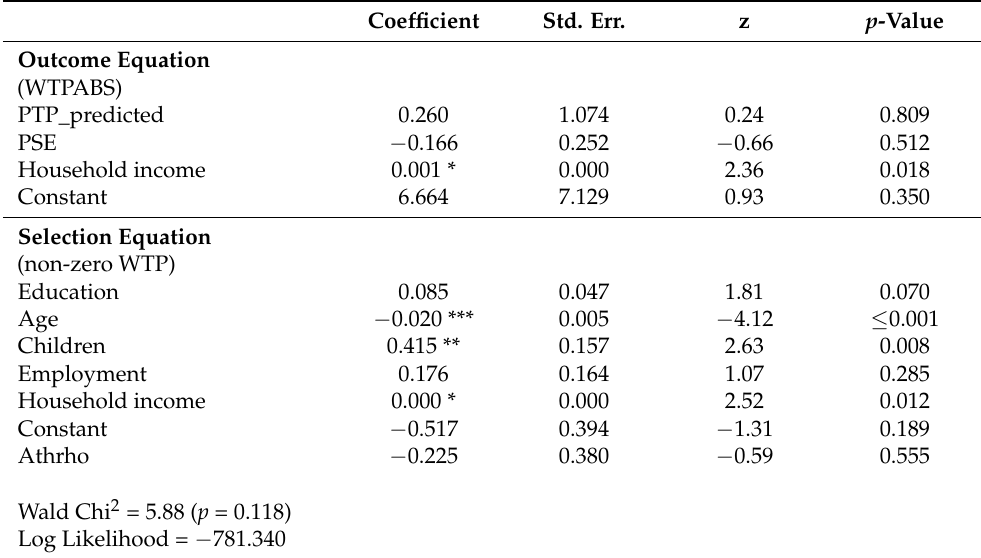
Table 5. Heckman results for the respondents with a non-zero